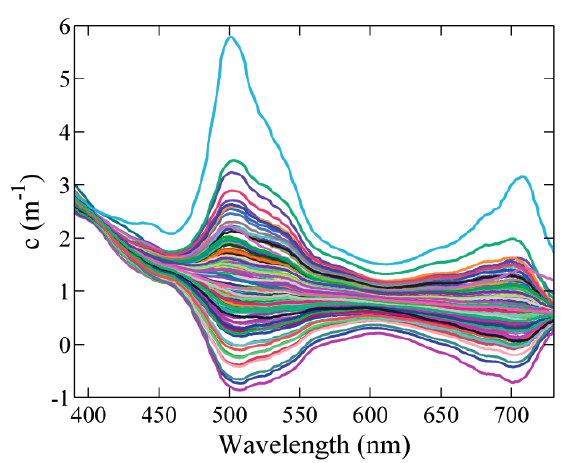
Figure 9. Example of artifacts in the measurements at specific spectral regions due to ambient light contamination during floating buoy deployment in Schaalsee Lake (Germany) in September 2014.